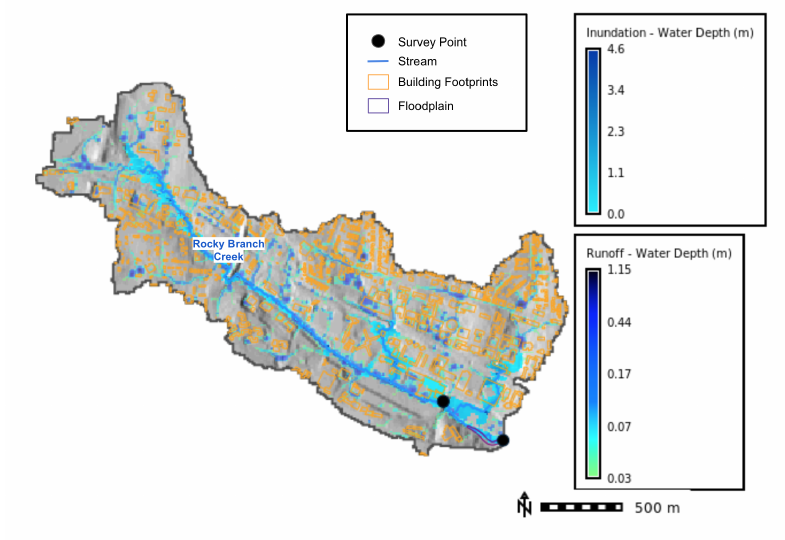
Figure 15. Cluster 3—Maximum inundation and 100-year precipitation events were simulated for Cluster 3, indicating pluvial flooding at depth up to 1.15 m and fluvial flooding up to 4.6 m deep.